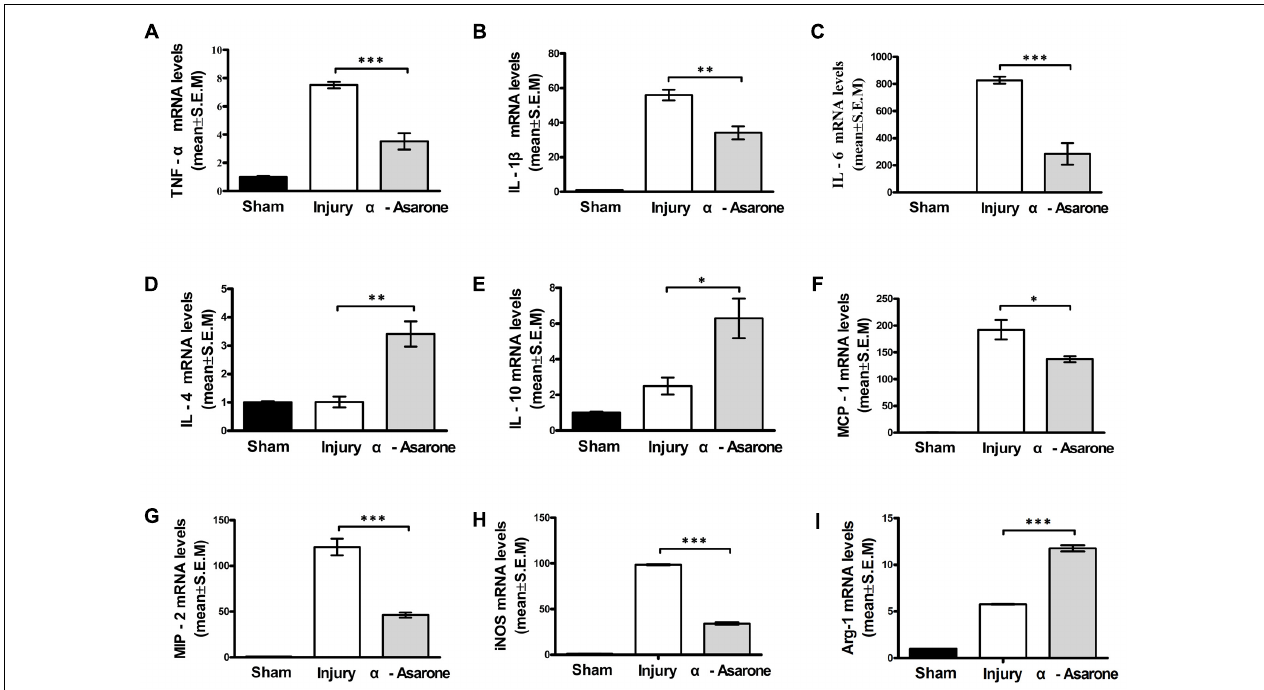
FIGURE 4 | Effects of α -asarone on mRNA expression levels of cytokines and chemokines in injured spinal cord as measured using real-time RT-PCR. (A) TNF- α , (B) IL-1 β , (C) IL-6, (D) IL-4, (E) IL-10, (F) monocyte chemotactic protein (MCP)-1, (G) macrophage inflammatory protein (MIP)-2, (H) inducible nitric oxide synthase, and (I) Arg 1 mRNA levels. The relative expression levels of target mRNAs were calculated using the (cid:49)(cid:49) Ct method and expressed relative to the value in the sham group (designated as 1). Data represent the mean ± standard error of the mean of three independent experiments ( n = 3). ∗ P < 0.05, ∗∗ P < 0.01, and ∗∗∗ P < 0.001. Statistical comparisons were performed using one-way analyses of variance followed by Tukey tests.